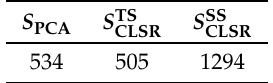
Table 5. Speedup factor of the PCA-based ( S PCA ) and CLSR methods with: the two-stream model ( S TS ) and single-scattering model ( S SS CLSR